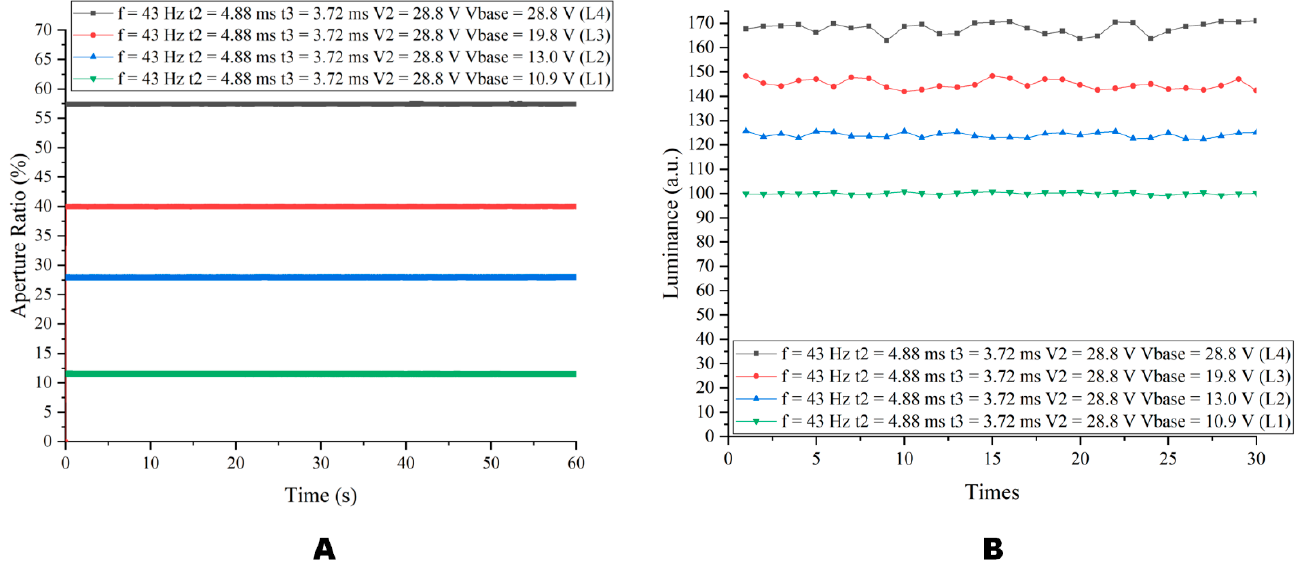
Figure 13. Aperture ratio and luminance at four V base levels. In the case of f = 43 Hz, t 2 = 4.88 ms, t 3 = 3.72 ms, and V max = 28.8 V, four levels of gray scales could be achieved by changing V base . ( A ) Aperture ratio at four V base . ( B ) Luminance at four V base .